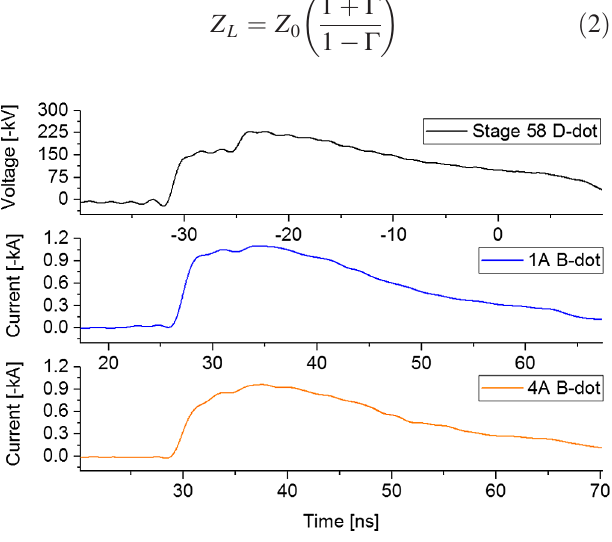
FIG. 7. Low-pass filtered (500 MHz cutoff) voltage and current traces from Shot 20 of the 25 kV series (unfiltered waveforms shown in Fig.